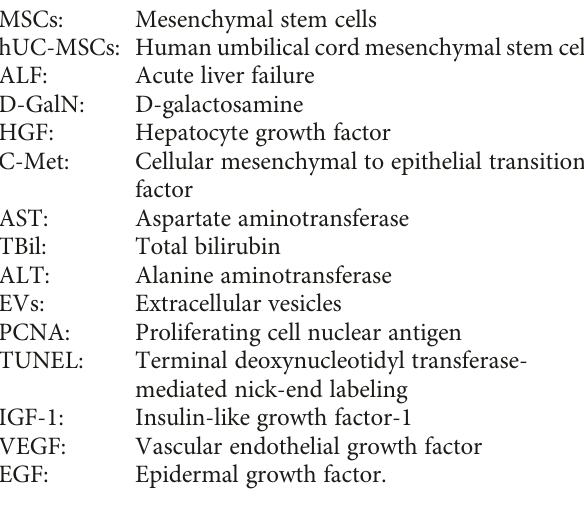
Figure 7: The protein levels of c-Met were analyzed by Western blotting in P3, P5, P8, and P10 hUC-MSCs. Data are presented as mean ± SD. ∗ P < 0 05 , ∗∗ P < 0 01